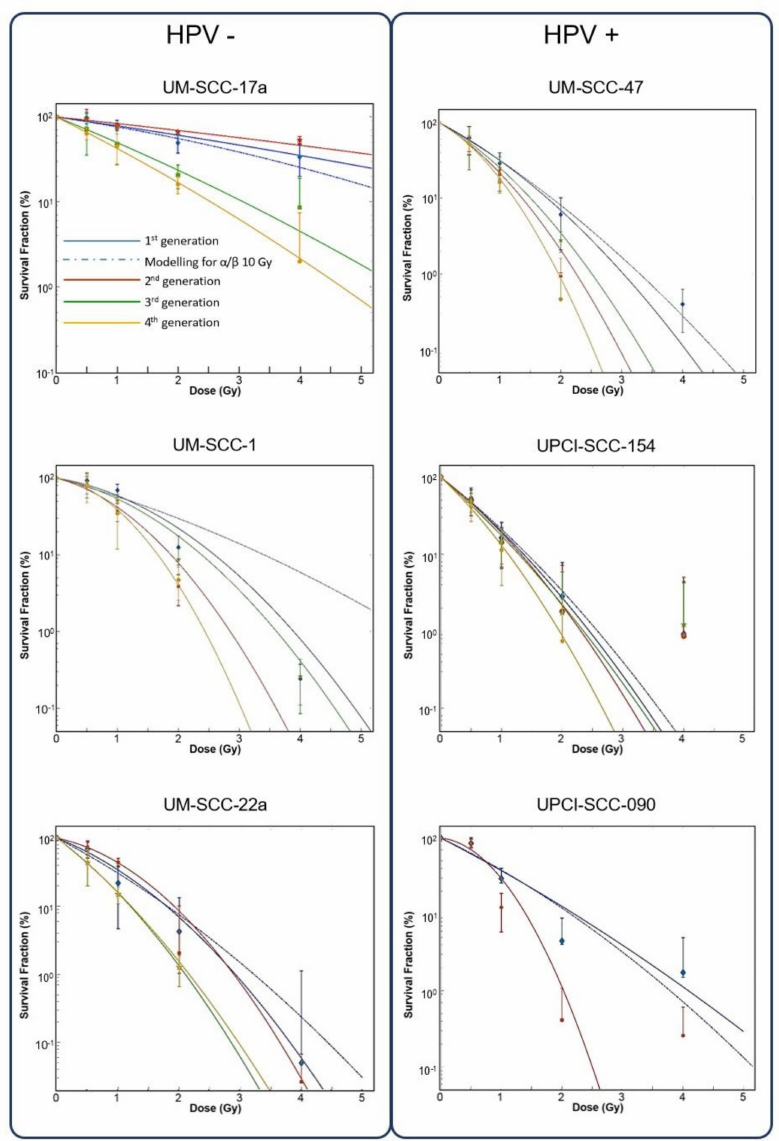
Figure 4. Survival curves for up to 4 generations of each cell line by HPV status. Dotted blue line shows 1st generation data modelling to HNSCC standard α / β ratio of 10 Gy. Clonogen SF shown on Y axis (log 10) as a function of absorbed dose (x axis).